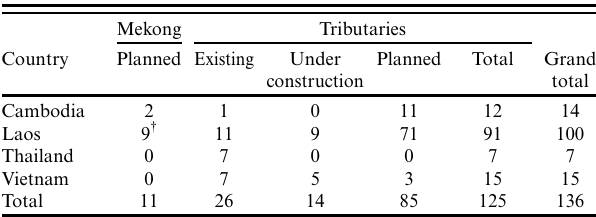
Table 2. Number of dams in the lower Mekong basin. Source: MRC (2011 b